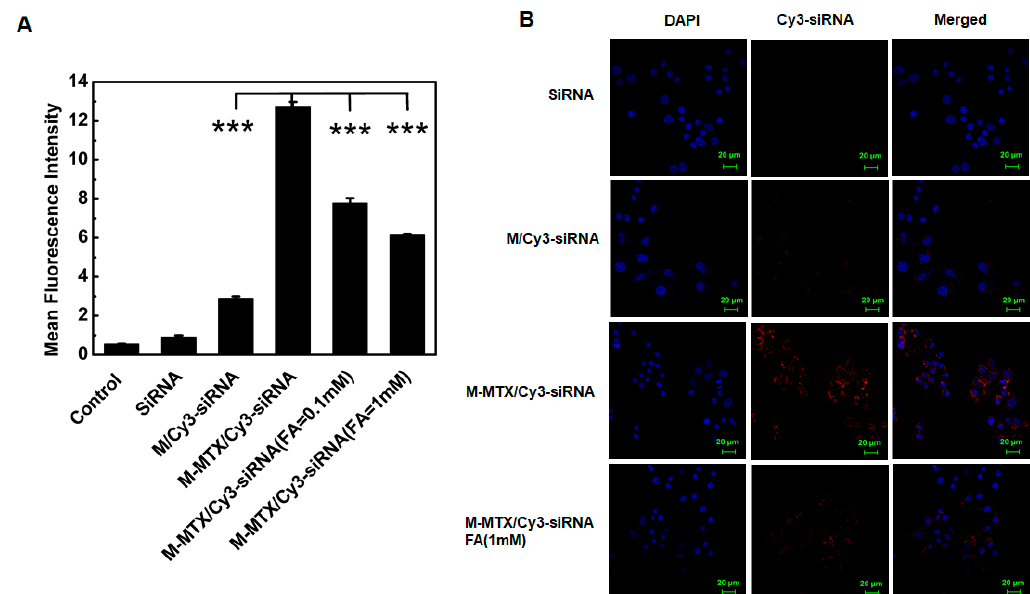
Figure 2. The cell uptake of M-MTX/Cy3-siRNA in the FR-expressing HeLa cells. ( A ) Flow cytometry was used to quantify the cellular uptake of different formulations. The HeLa cells were incubated with M-MTX/Cy3-siRNA, M/Cy3-siRNA, and Cy3-siRNA for 4 h at 37 ◦ C. Two concentrations of free folic acid (FA) (0.1 mM and 1 mM) was added 1 h before the M-MTX/Cy3-siRNA (100 nM) was incubated. *** p < 0.001. ( B ) The confocal micrographs of HeLa cells were also obtained after incubation with M-MTX/Cy3-siRNA, M/Cy3-siRNA, and Cy3-siRNA for 4 h at 37 ◦ C. Free FA (1 mM) was also added 1 h before the M-MTX/Cy3-siRNA (100 nM) addition. The green bar in the image was 20 µ m. The values were the mean ± SEM (n = 3).